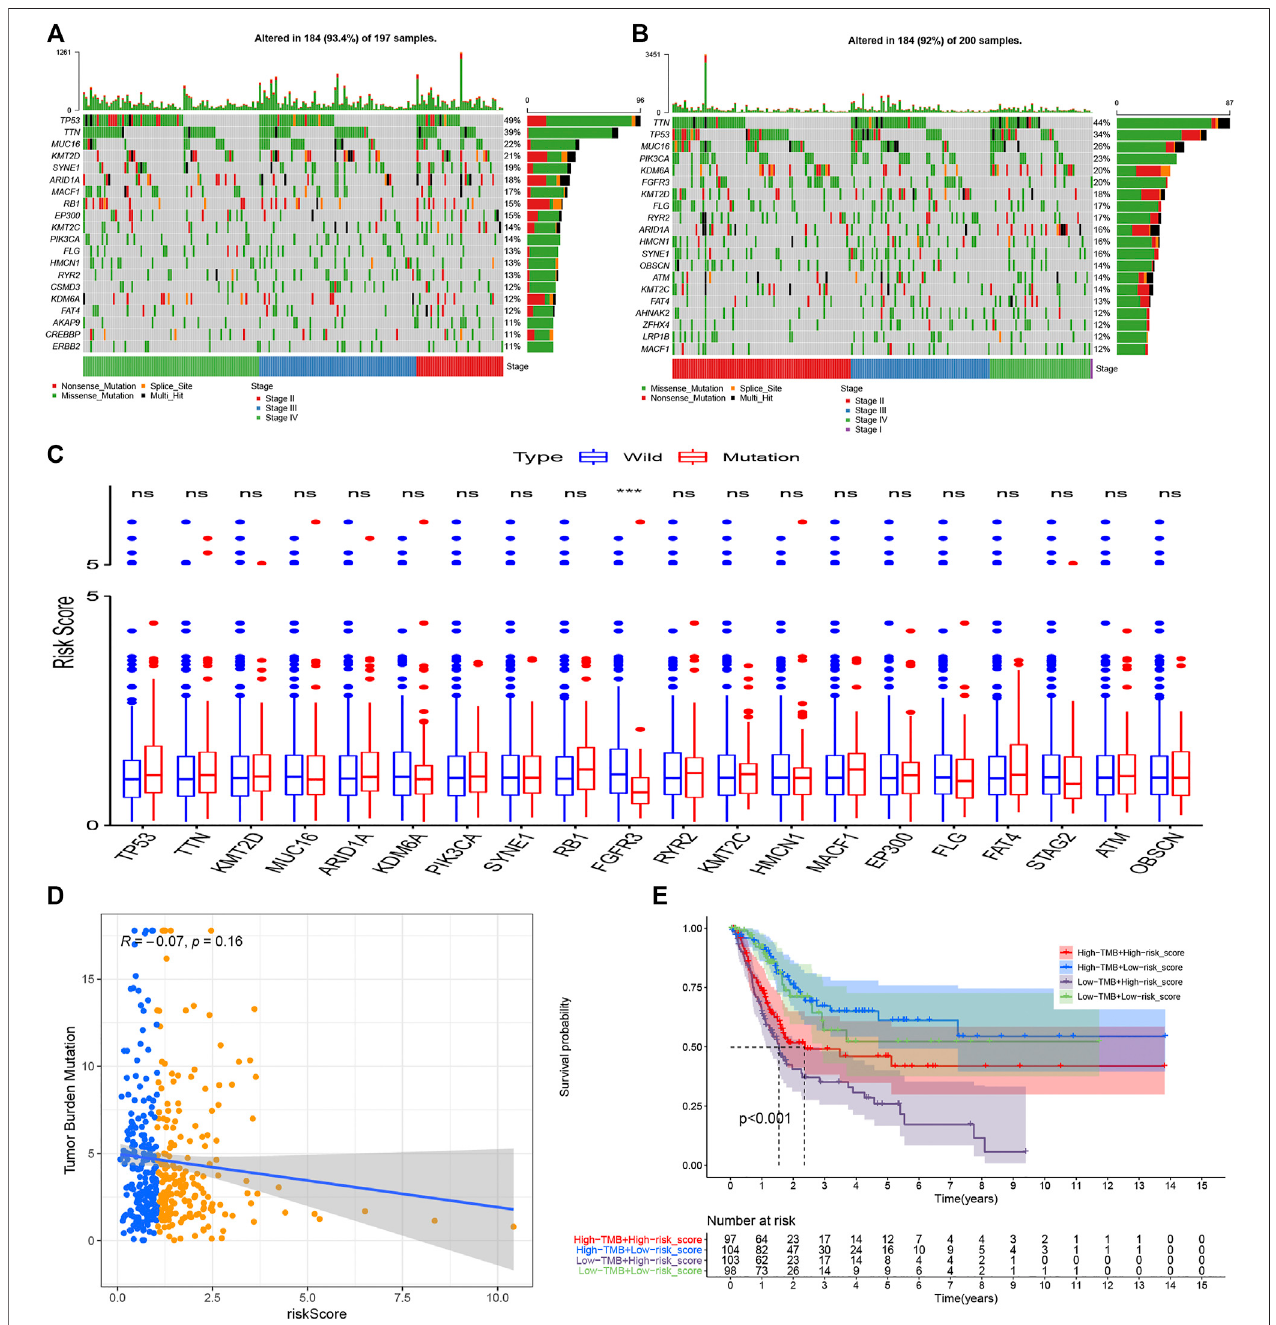
FIGURE10| Tumormutationalburdenanalysis.The top20mutationalgeneswerelisted inthehigh riskgroup (A) and lowriskgroup (B) .Theriskscoresbetween the wild type and the mutation type of the top frequent mutational genes were compared (C) . The risk scores were higher in the wild types of FGFR3 compared with the mutational types of FGFR3 . TMB decreased slightly with R (cid:1) − 0.07 and p (cid:1) 0.16 (D) , and the Kaplan – Meier curves showed that patients with higher TMB and low-risk scorestendedtohavethebestoverallsurvivalandthosewithlowTMBandhighriskscoresusuallyhadworsesurvivalprobabilities (E) .* p < 0.05;** p < 0.01;*** p < 0.001; ns: no signi fi